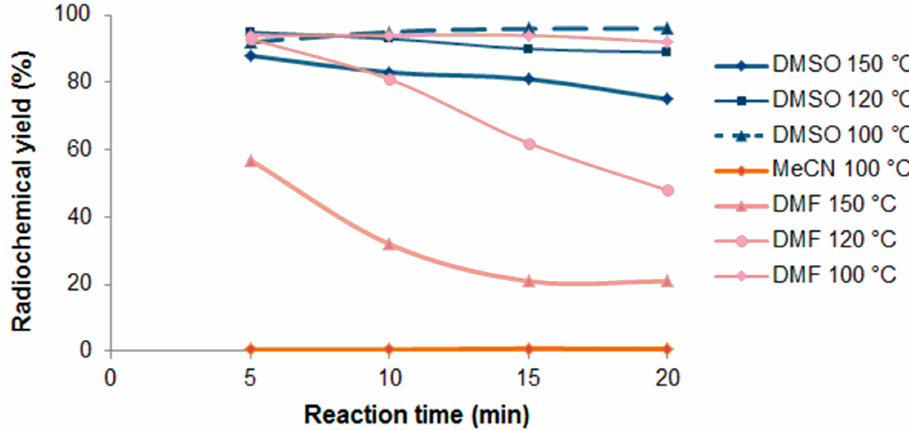
Figure 2. The radiochemical yield of [ 18 F] BIT1 depending on reaction time, temperature, and solvent. (Conditions: K[ 18 F]F-K 2.2.2 , thermal heating, 1.0 mg of 5 ). BIT, benzoimidazotriazine.